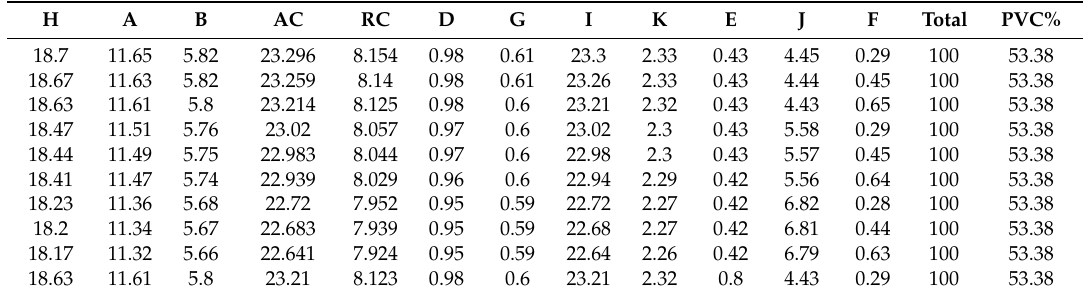
Table 6. Total sum to 100 of population count (in percentage/100